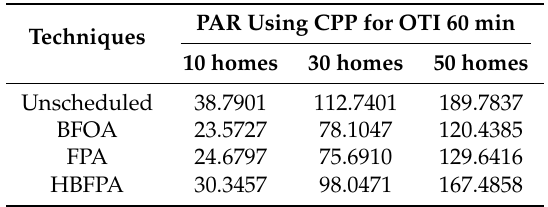
Table 20. Peak to average ratio for 24 h (for multiple homes).